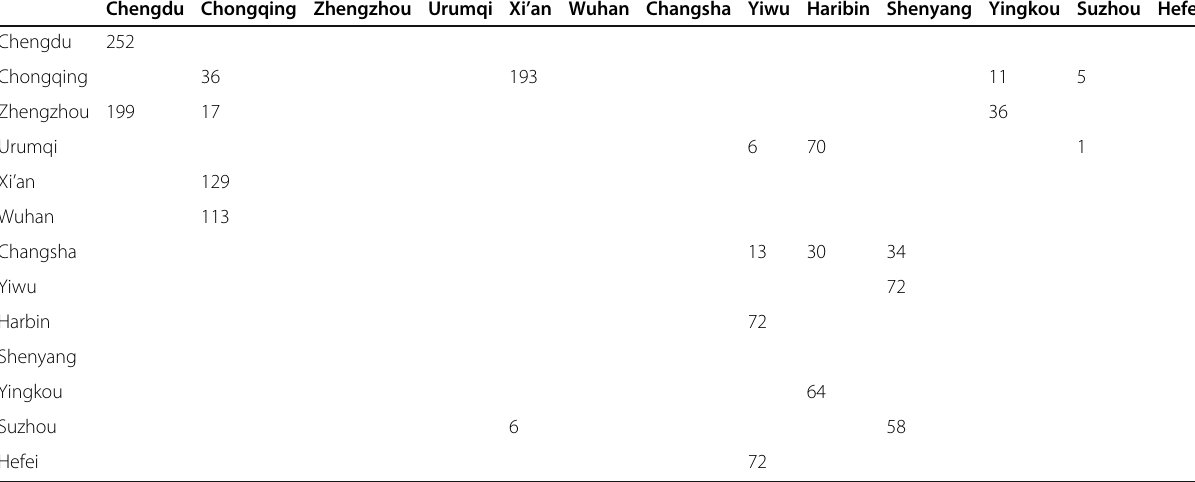
Table 2 Chinese part of empty container transportation scheme (FEU)